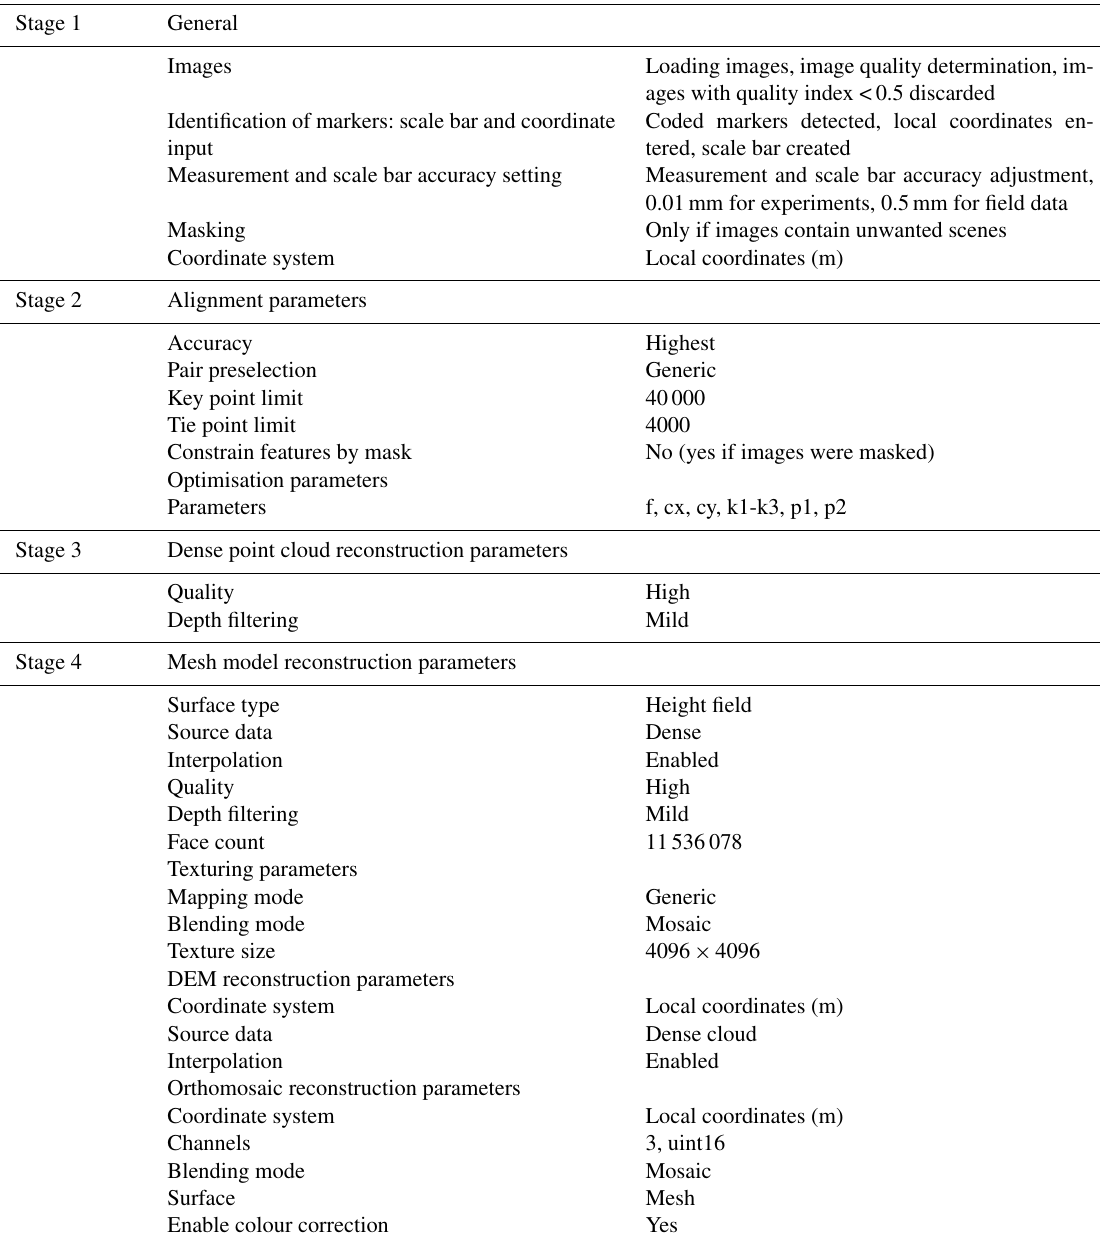
Table 2. Summary of processing parameters in the development of a DEM in PhotoScan. Stage 1 General Images Loading images, image quality determination, im- ages with quality index <0.5 discarded Coded markers detected, local coordinates en- tered, scale bar